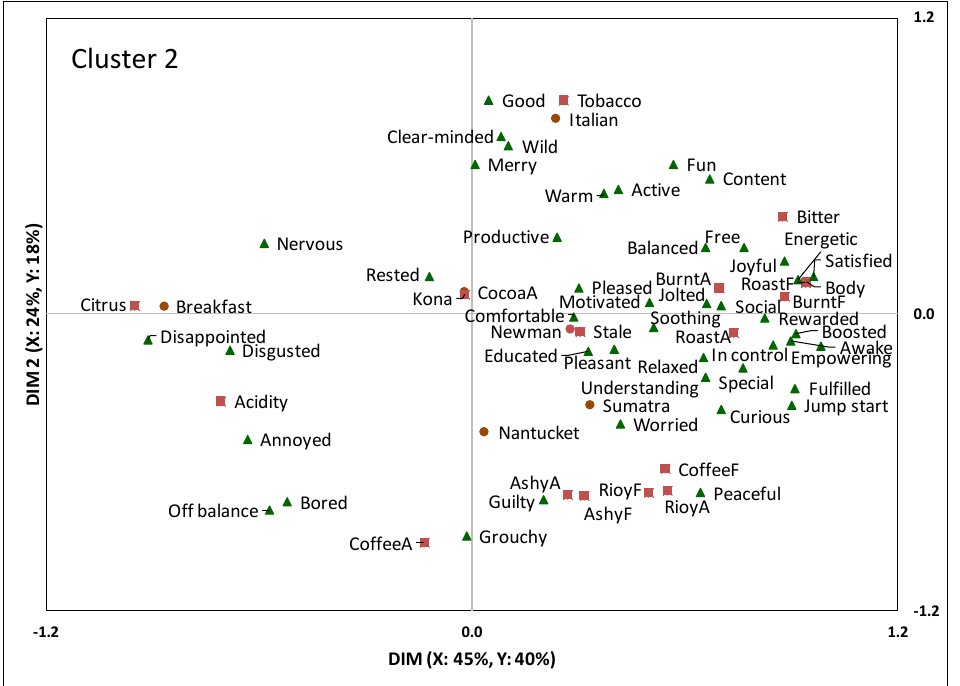
Figure 3. Partial least square regression analysis of descriptive sensory and CDE emotion lexicon of the six coffee samples for consumer Cluster 1.